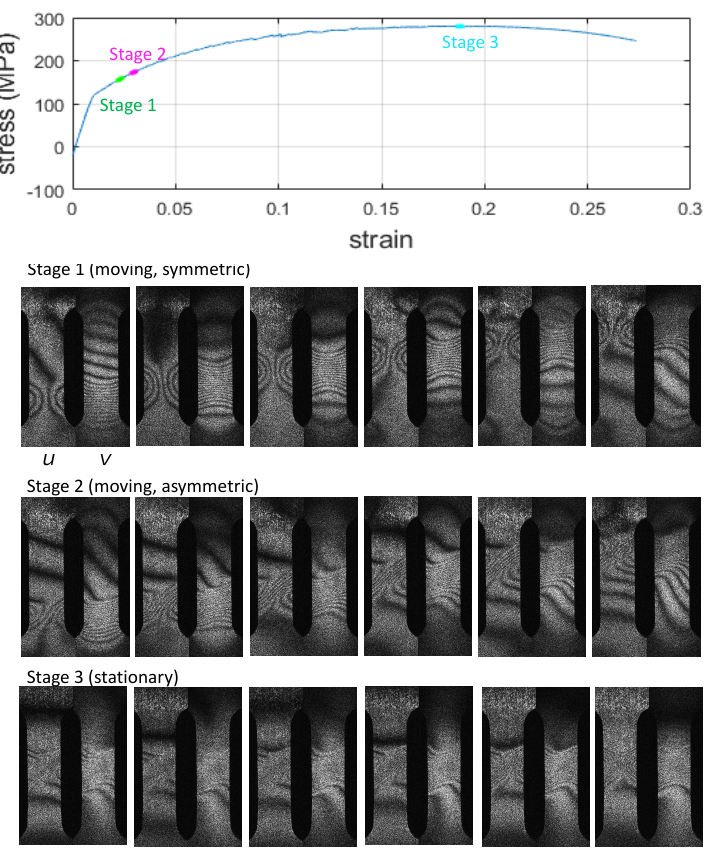
Figure 6. Change in wave motion. For each stage pairs of fringe patterns are arranged.